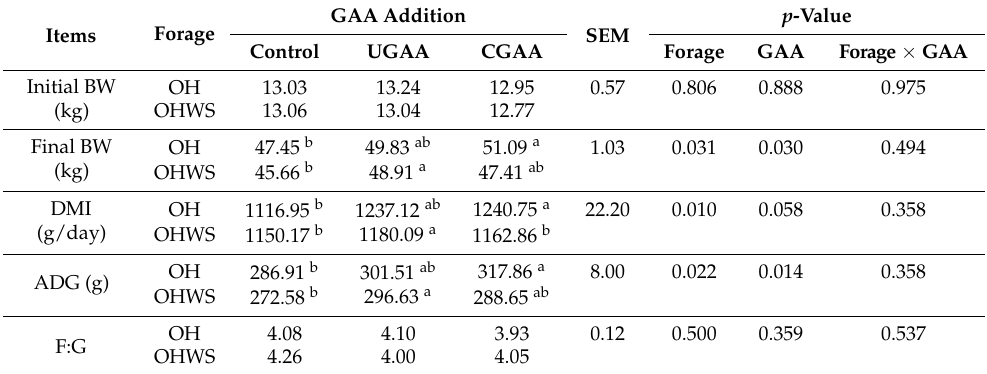
Table 3. Effects of forage type and GAA addition on growth performance in lambs.